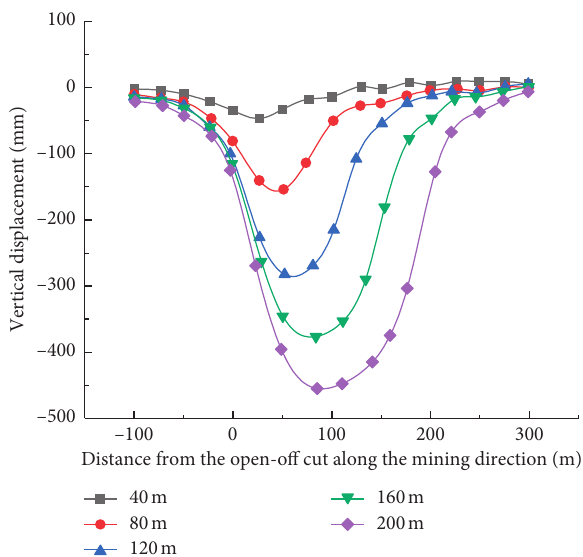
Figure 8: The expansion deformation changes of the protected layer with the advancing of the rock-coal composite protective